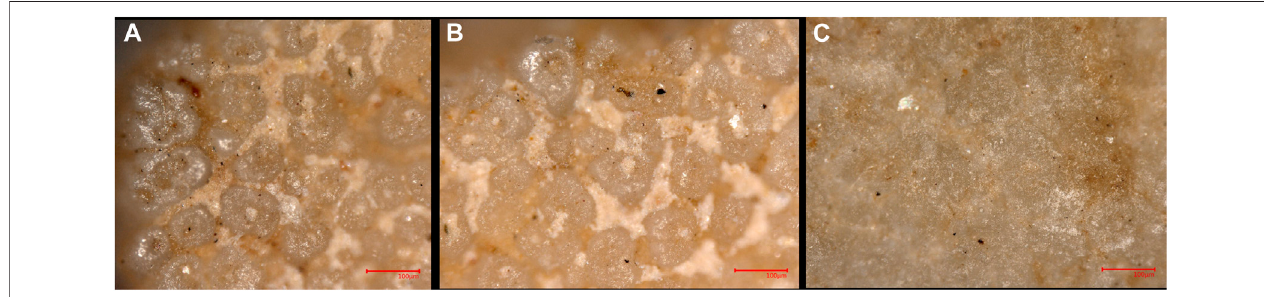
FIGURE 6 | Interior surfaces of OES fragments from Shizitan 9 Layer 4 at × 500 magni fi cation. (A) . Undrilled fragment recovered by sieving. (B) . Fragment with drilling from one side, recovered by sieving. (C) . Piece drilled from two sides that was shaped into an irregular circular ornament; recovered by sieving. (A, B) show dissolvedtipsofmammillaryconesandexposedporecanalsindicativeofhumansatShizitanacquiringOESrawmaterialfromeggsthathadincubatedandhatched.On (C) , parallel striations are visible indicating that completed beads are polished during a fi nal step in their manufacture, and this obscures the mammillary cones.